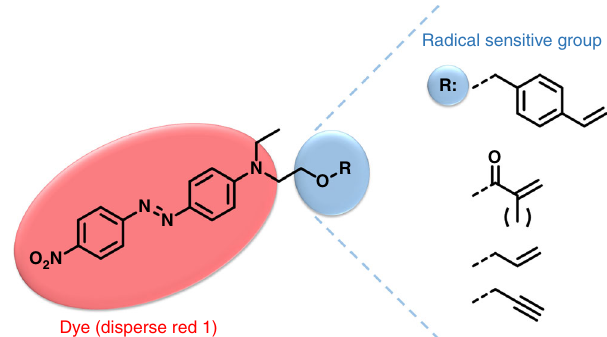
Fig. 1 Structure of the dye disperse red 1 (DR1) with the different radical sensitive groups. (Red) The chemical structure of DR1. (Blue) The radical sensitive groups necessary for the covalent immobilization, from top to bottom: styryl, (meth)acrylate, allyl, and